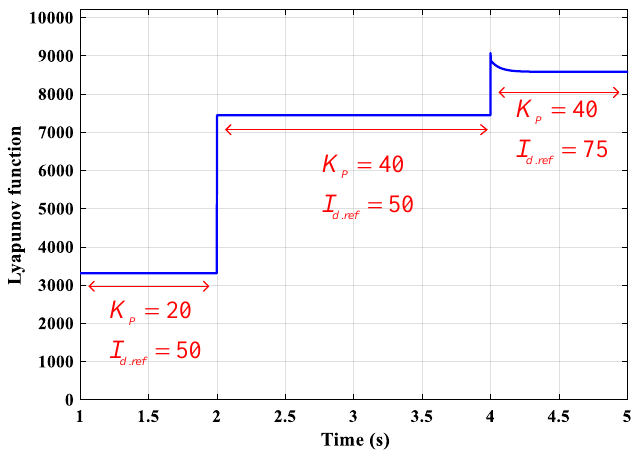
Figure 8. Lyapunov function of the grid-connected VSC considering different values of the K P and a step change in the reference current at t = 4 s.